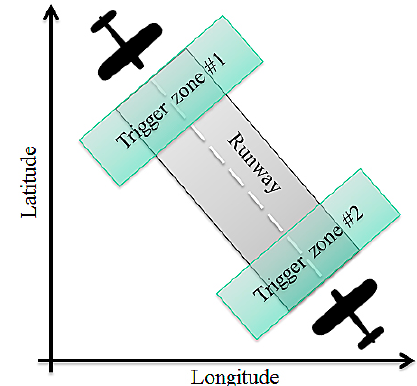
Fig. 15. Juxtaposition of fourteen flight circuits